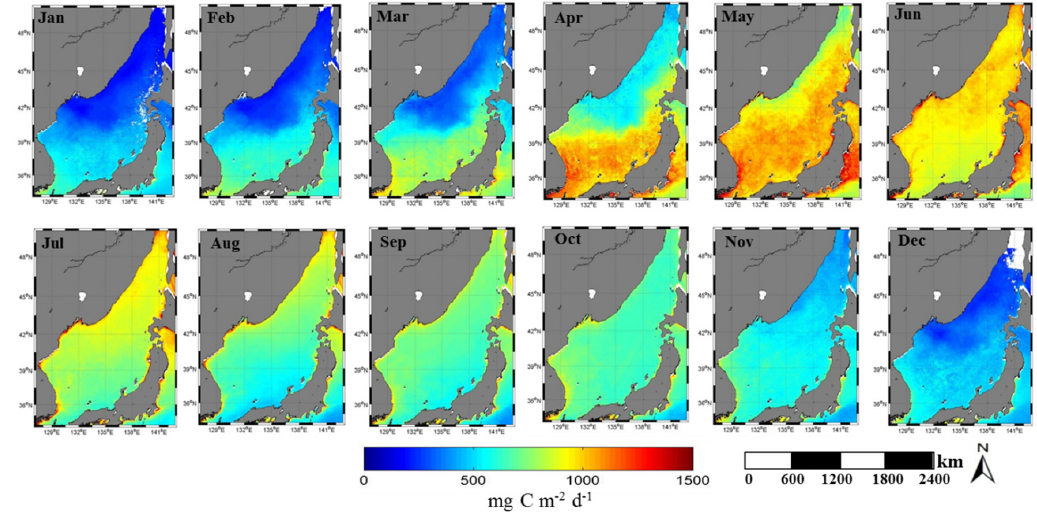
Figure 4. Spatial distribution of climatological monthly primary productivity in the East Sea.